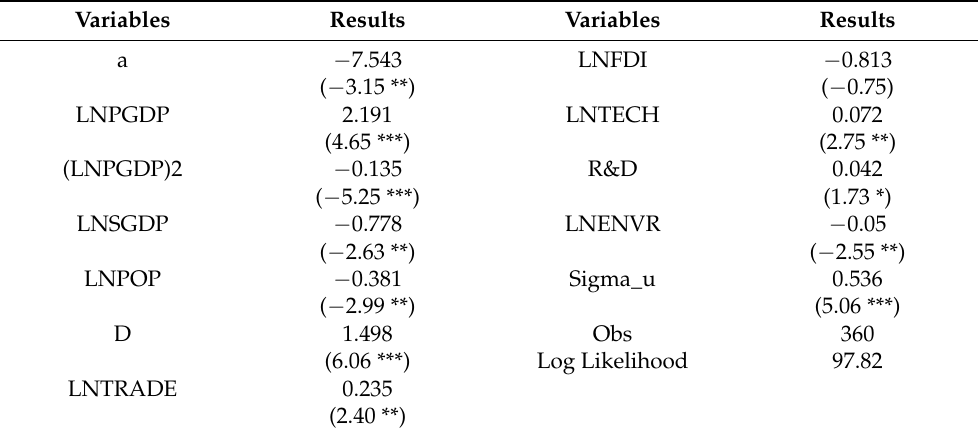
Table 7. Robustness test